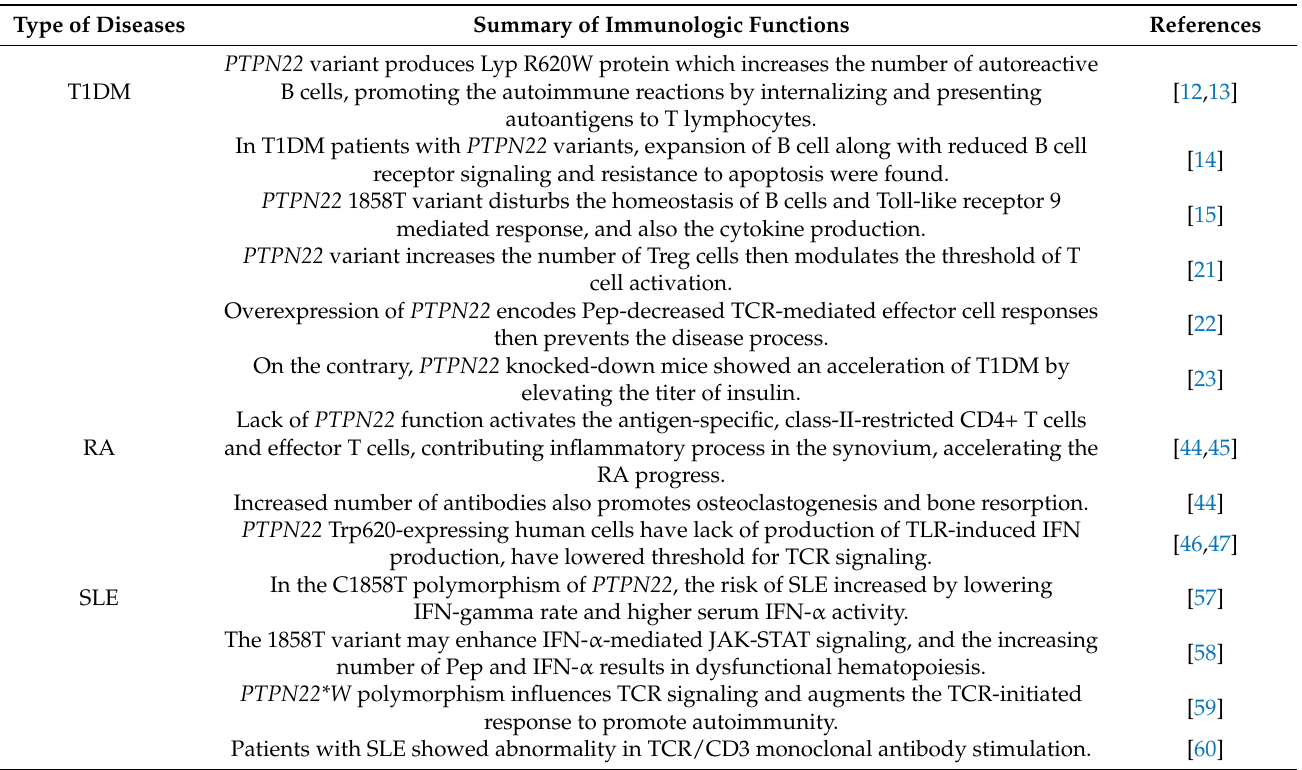
Table 1. Summary of the PTPN22 C1858T polymorphism with different types of autoimmune